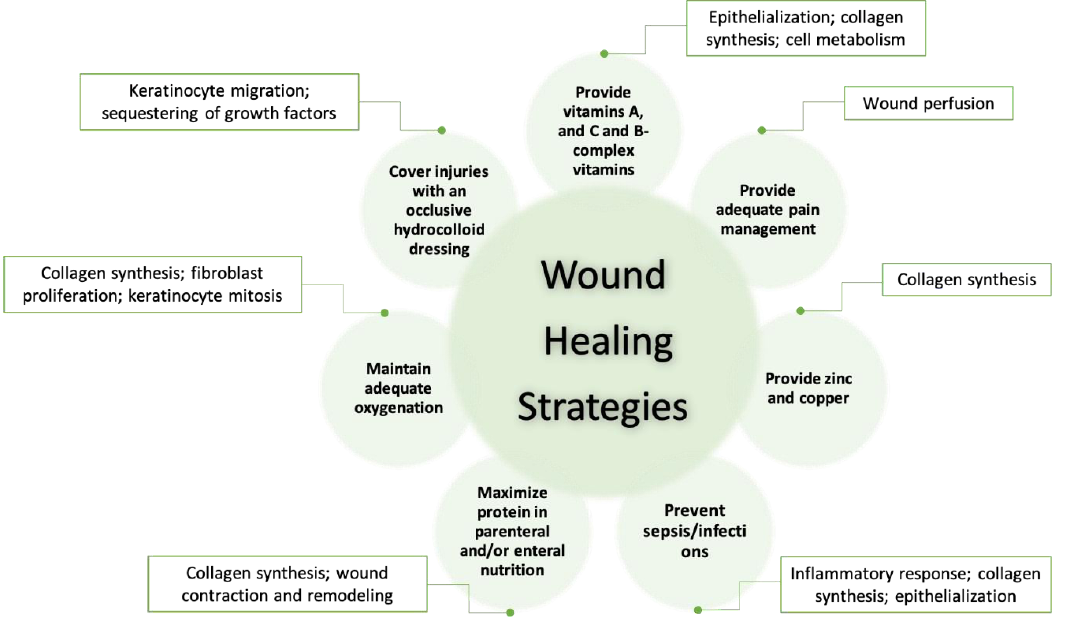
Figure 5. Strategies to promote wound healing in newborns/infants (adapted from [102]).